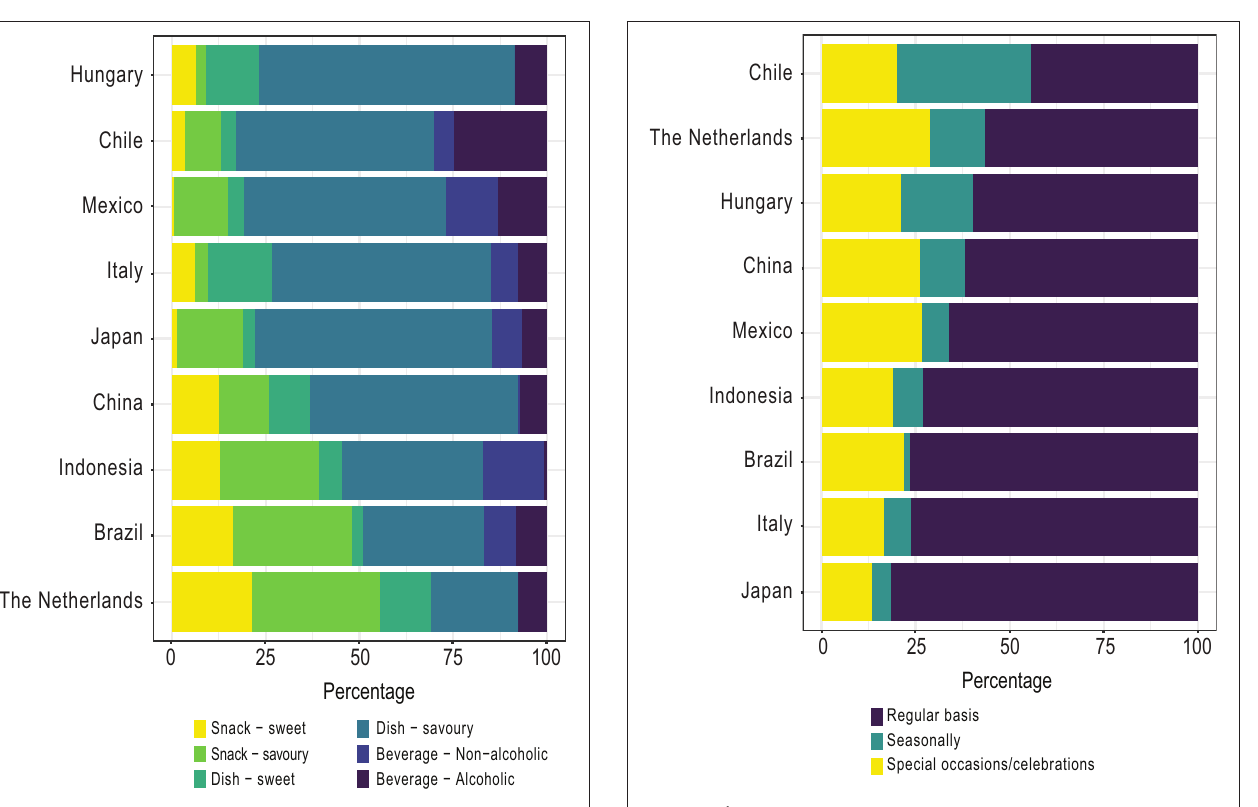
FIGURE 3 | Type of traditional foods and beverages by country. Percentage of type of foods/beverages relative to the number of traditional foods and beverages most frequently mentioned by country (stated by ≥ 13% of respondents).